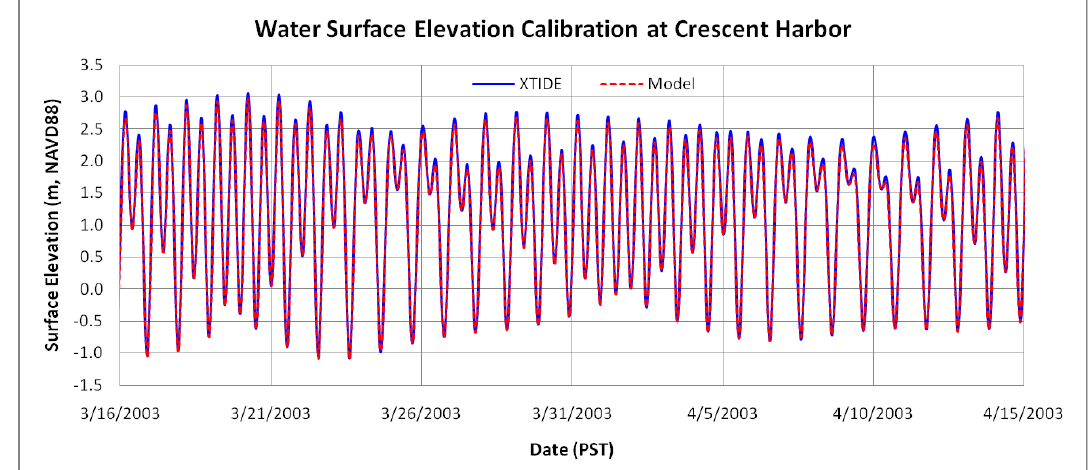
Figure 4. Comparison of water-surface elevations between model results and XTide prediction at Crescent Harbor